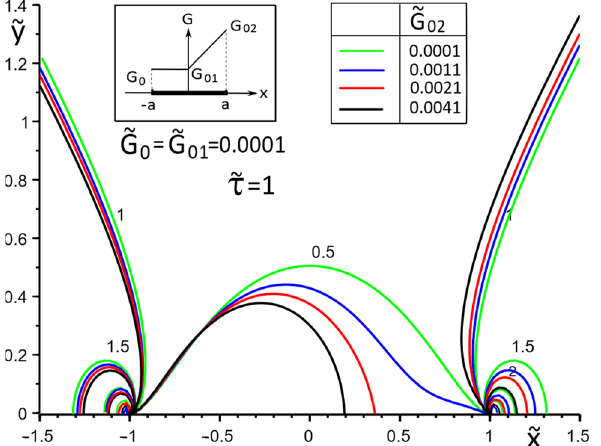
Figure 9. Stress distribution in the matrix at the vicinity of the inclusion with a linear distribution of material stiffness.